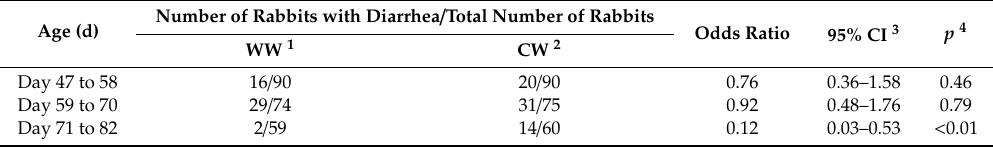
Table 1. Odds ratios for the incidence of warm water-associated diarrhea.